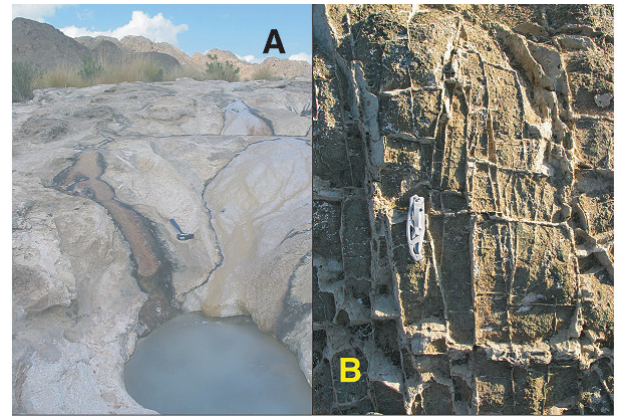
Figure 8. [A] Travertine at an alkaline spring in a peridotite catchment, near the village of Falaij, Oman. [B] Carbonate veins in serpentinized peridotite, near the town of Birkat al Mawz,